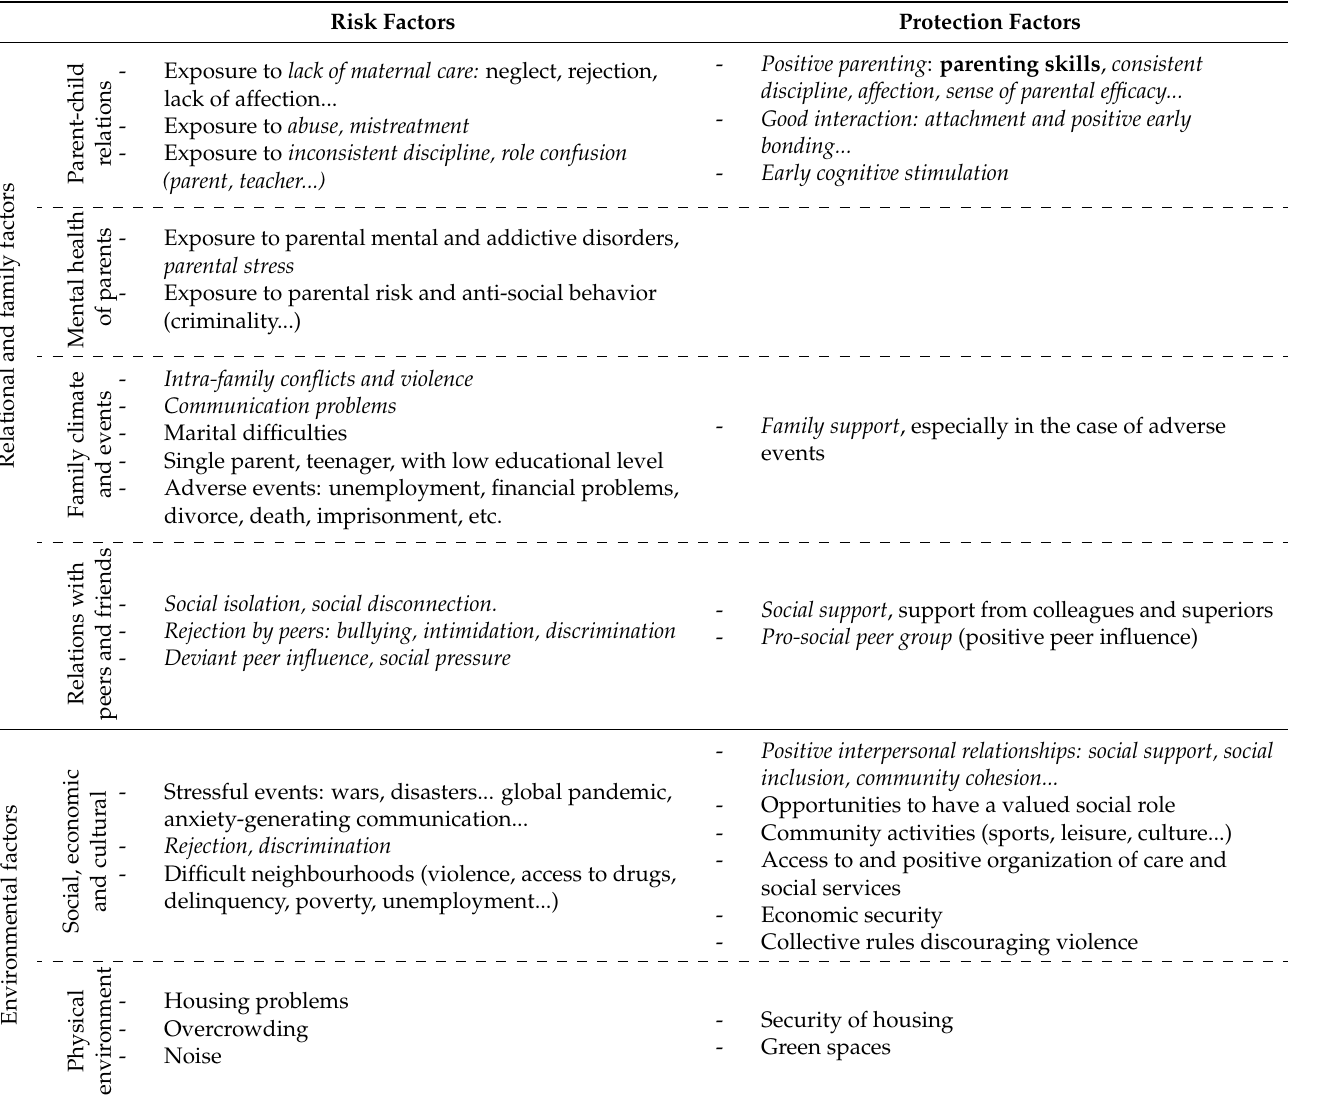
- Positive parenting : parenting skills , consistent discipline, affection, sense of parental efficacy... - Good interaction: attachment and positive early bonding... - Early cognitive stimulation